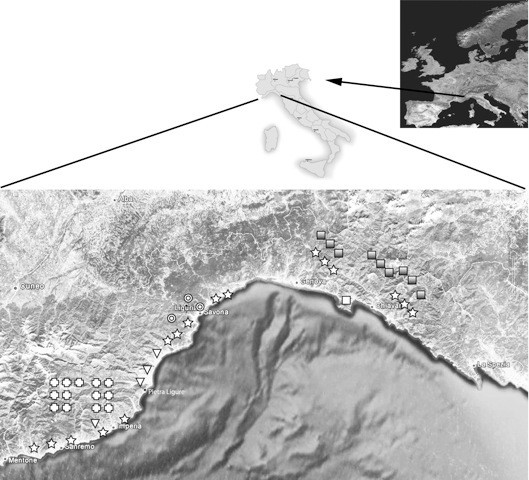
Map showing area of residency of patients in Liguria region and location within Italy and Europe. Signs show area of residency and hospital Infectious Diseases Unit where seen as inpatients. Star: children seen at Gaslini Hospital, Cross: patients seen at Sanremo Unit, Triangles: patients seen at Pietra Ligure Unit, Circles: patients seen at the Savona Unit, Greyed Squares: Patients seen at the Galliera Hospital Unit, Open Square: patients seen at the IRCCS S. Martino Hospital Unit.